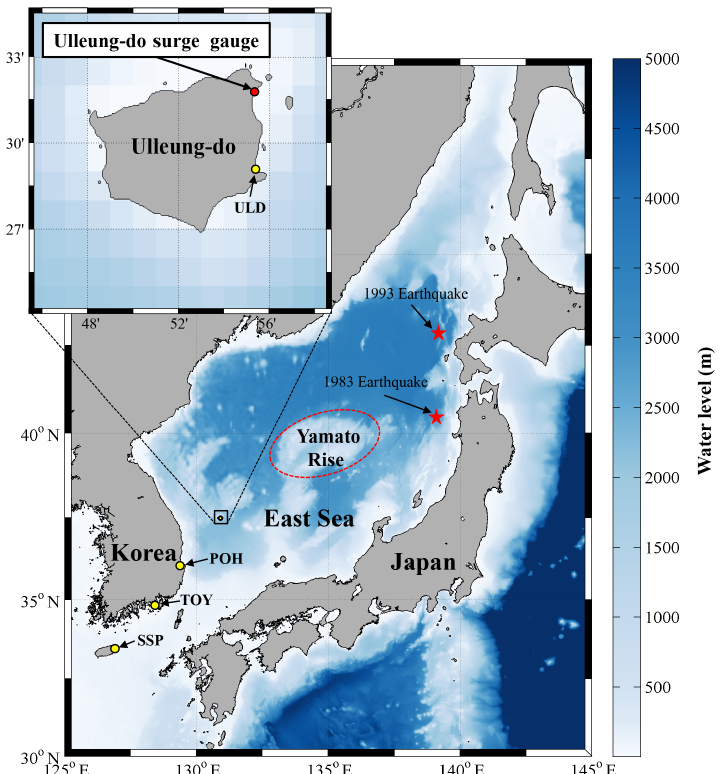
Figure 1. Study area and locations of the Ulleung-do surge gauge (red circle), tide stations (yellow circles), Yamato Rise (red dotted circle), and the epicenters of the 1983 and 1993 earthquakes (red